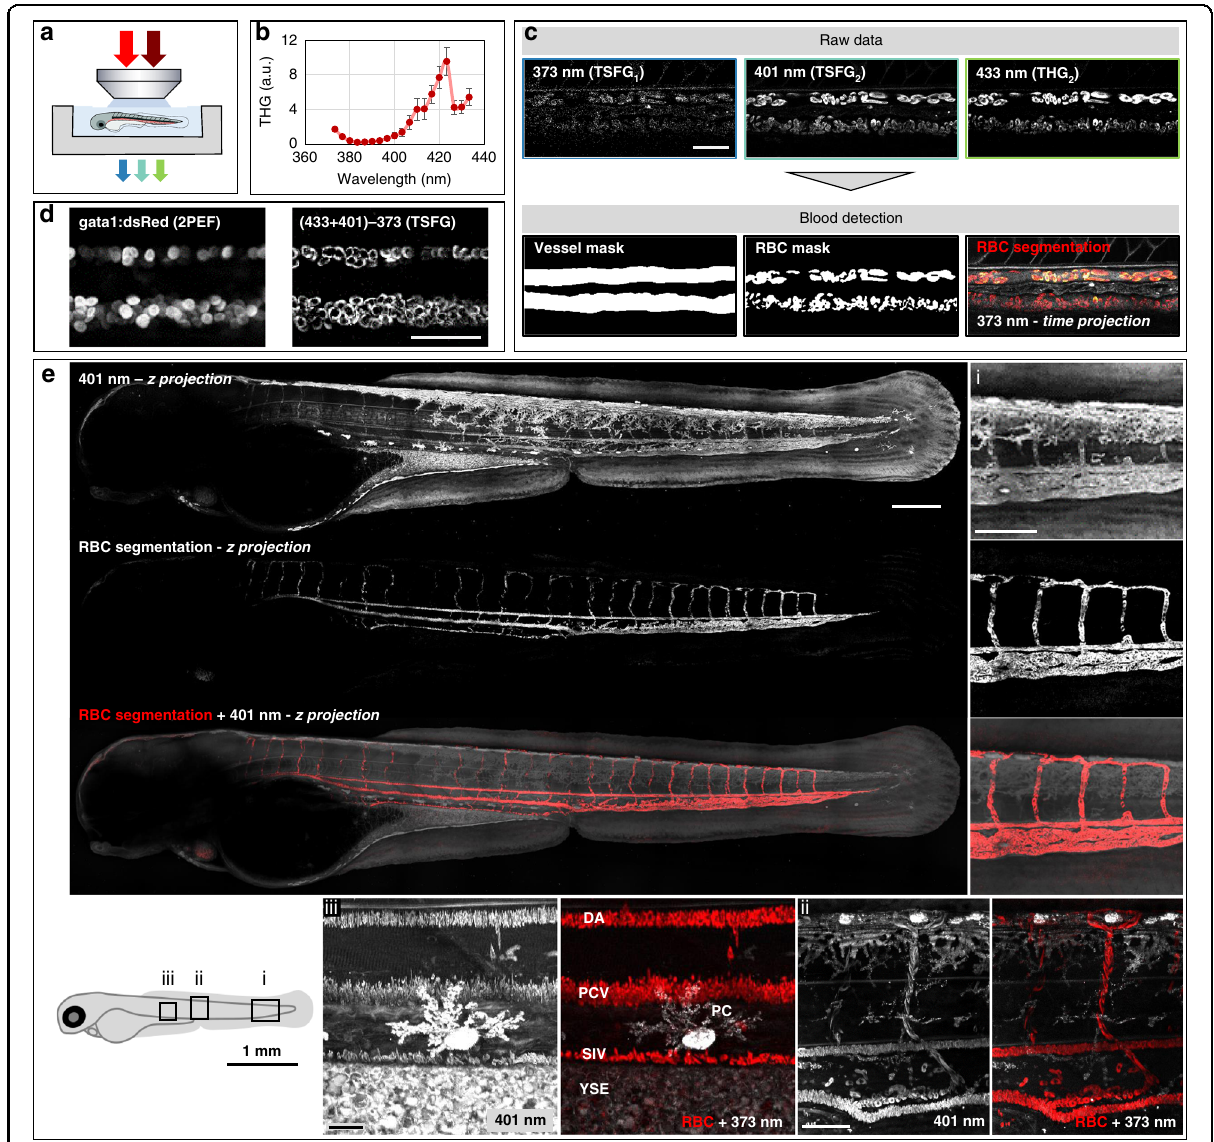
Fig. 3 RBC detection in live zebra fi sh embryos with color TSFG microscopy. a Experimental scheme. b Average single-beam THG spectrum measured from fl owing RBCs in live embryos ( N = 3 embryos). c Segmentation of vessels and RBCs from color TSFG images acquired simultaneously at 373, 401 and 433 nm in a region encompassing DA and PCV in 2 dpf embryos. Scale bar: 50 μ m. d Simultaneously acquired TSFG and fl uorescence images of RBCs in a 2 dpf Tg(gata1a:DsRed) embryo. In this experiment, we induced transient cardioplegia using MS222 to immobilize the RBCs. Scale bar: 50 μ m. e TSFG image of an entire embryo recorded in a tile-like fashion over a thickness of 100 µm. Shown are a z-projection of the 401 nm channel revealing blood vessels and other structures, the automated segmentation of the vascular system (see text and methods), and the overlay with the blood shown in red. (i), (ii) and (iii) show zoomed-in details of the tail and trunk, illustrating the effective discrimination provided by color TSFG signals between red blood cells and other structures producing strong signals such as pigmented cells, lipidic structures and other interfaces. DA dorsal aorta, PCV posterior cardinal vein, SIV subintestinal vein, PC pigment cell, YSE yolk sac extension. See also Movies M3 – 6, and supplementary Figs. S7 –